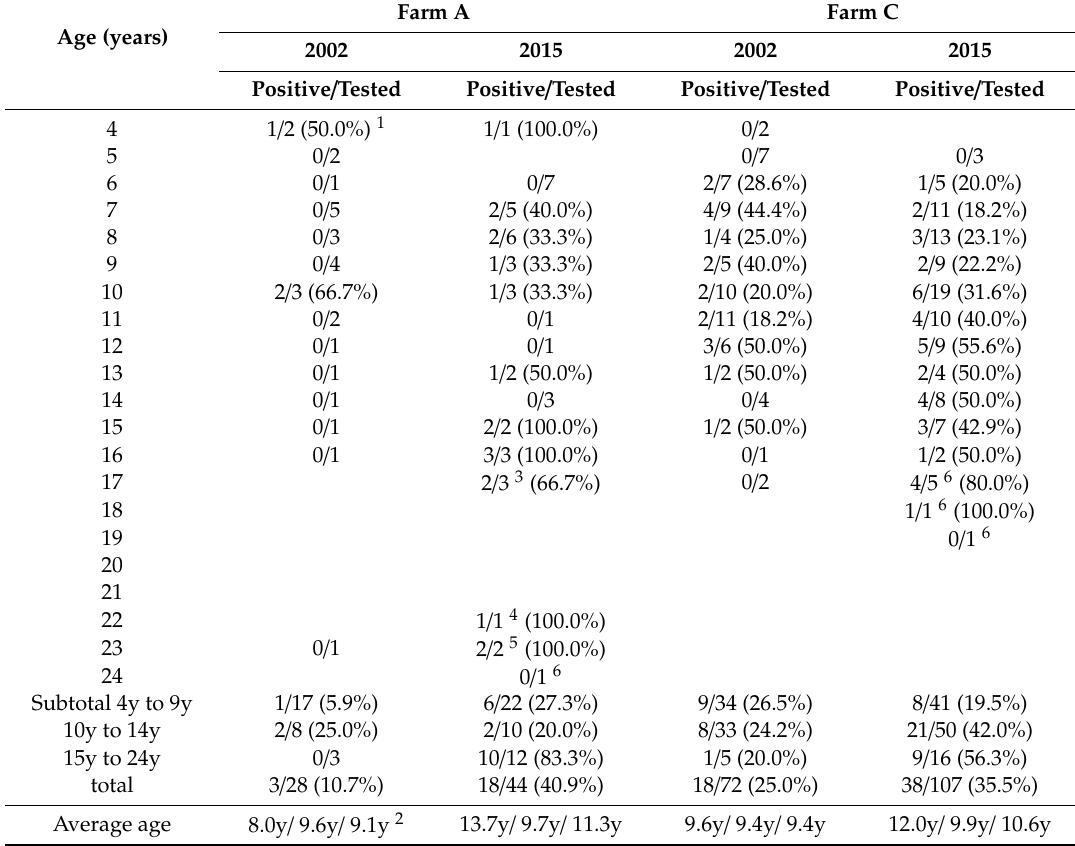
Table 6. Relationship between average ages of EFV antibody-positive horses and EFV antibody-positive